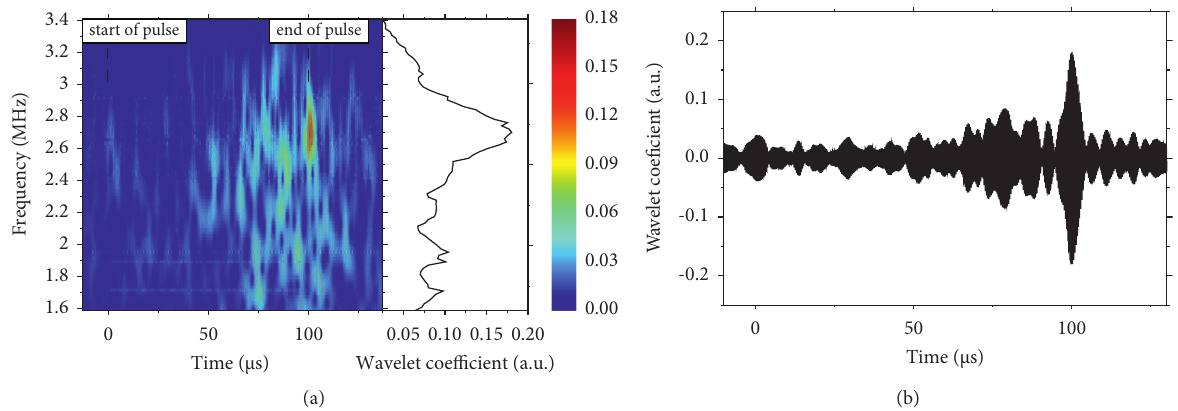
Figure 7: (a) Contour plot of the absolute wavelet coefficient as a function of time and frequency and maximum wavelet coefficient depending on the frequency. (b) Time-dependent wavelet coefficient at 2.70MHz. Both graphs show the impact of the first 1.14GeV U-ion pulse on pristine isotropic